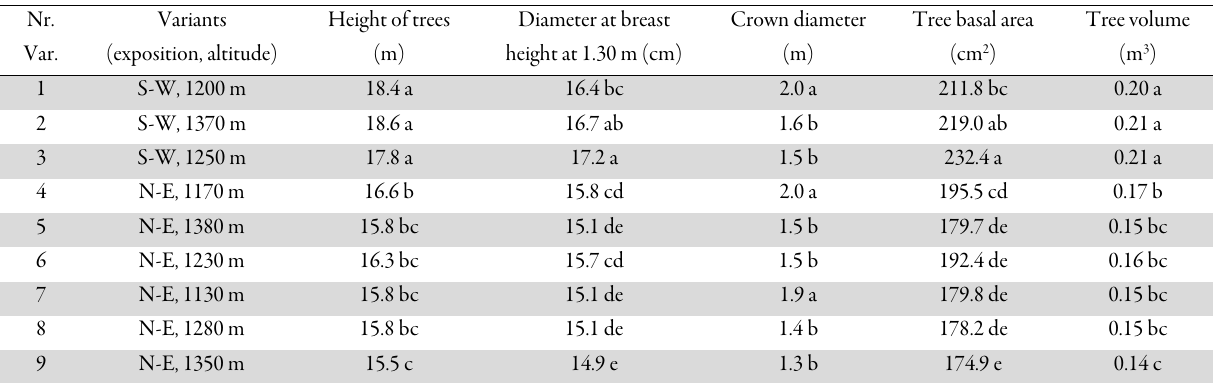
Table 1. Elements of the growth and biomass accumulation of the spruce trees ( Picea abies ) in nine plots, depending on the exposition and altitude Nr. Var.